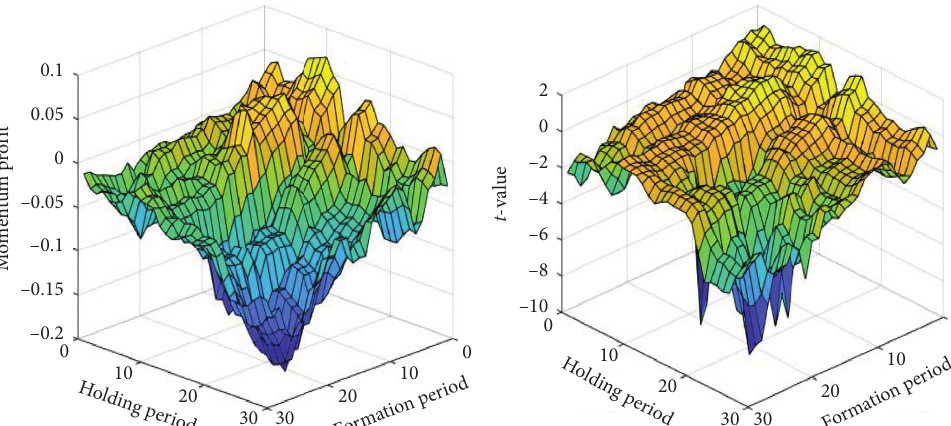
Figure 11: Lowest accumulative relative order imbalance in extensions of the B-share market. This figure shows the momentum profits and t -statistics under the lowest accumulative relative order imbalance in extensions of the B-share market. The formation and holding periods, respectively, range from 1 day to 30